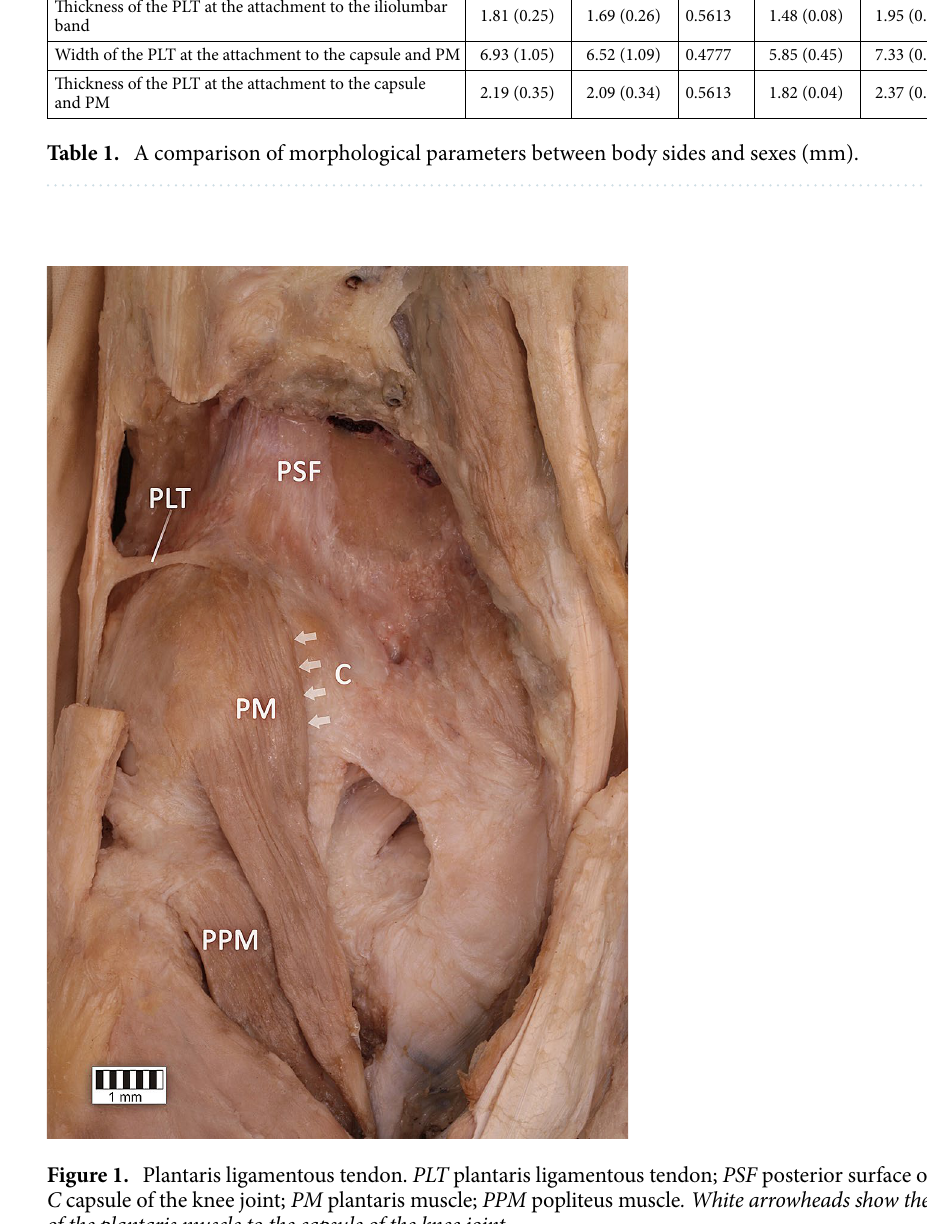
tem tissue lysis and sample preparation. An image at 25 × magnification is presented together with close-ups at 400 × (a and b). Figure 3a. 400 × magnification: An approximation of a fragment of the PLT can be seen, indicated by the course of the collagen fibers. The fibroblasts forming the parallel fibers contain elongated and flattened nuclei. An important feature of the architecture of the indicated tissue is that a small amount of basic substance can be seen between the collagen fibers. These qualities are all characteristic of tendons. Figure 3b. 400 × magnification: The photograph shows an approximation of a fragment of the PLT. The col- lagen fiber system differs from that seen in Fig. 2, the fibers being arranged in multidirectional waves rather than lying close and parallel to each other. Fibroblast nuclei are visible in different planes between the collagen